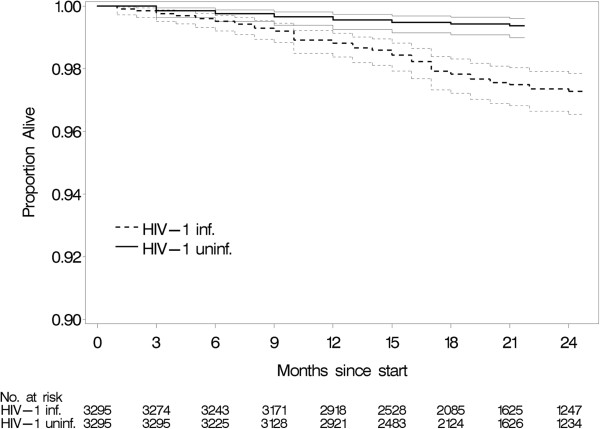
Kaplan-Meier curve showing mortality with 95% CI caused by medical illness by participant serostatus.